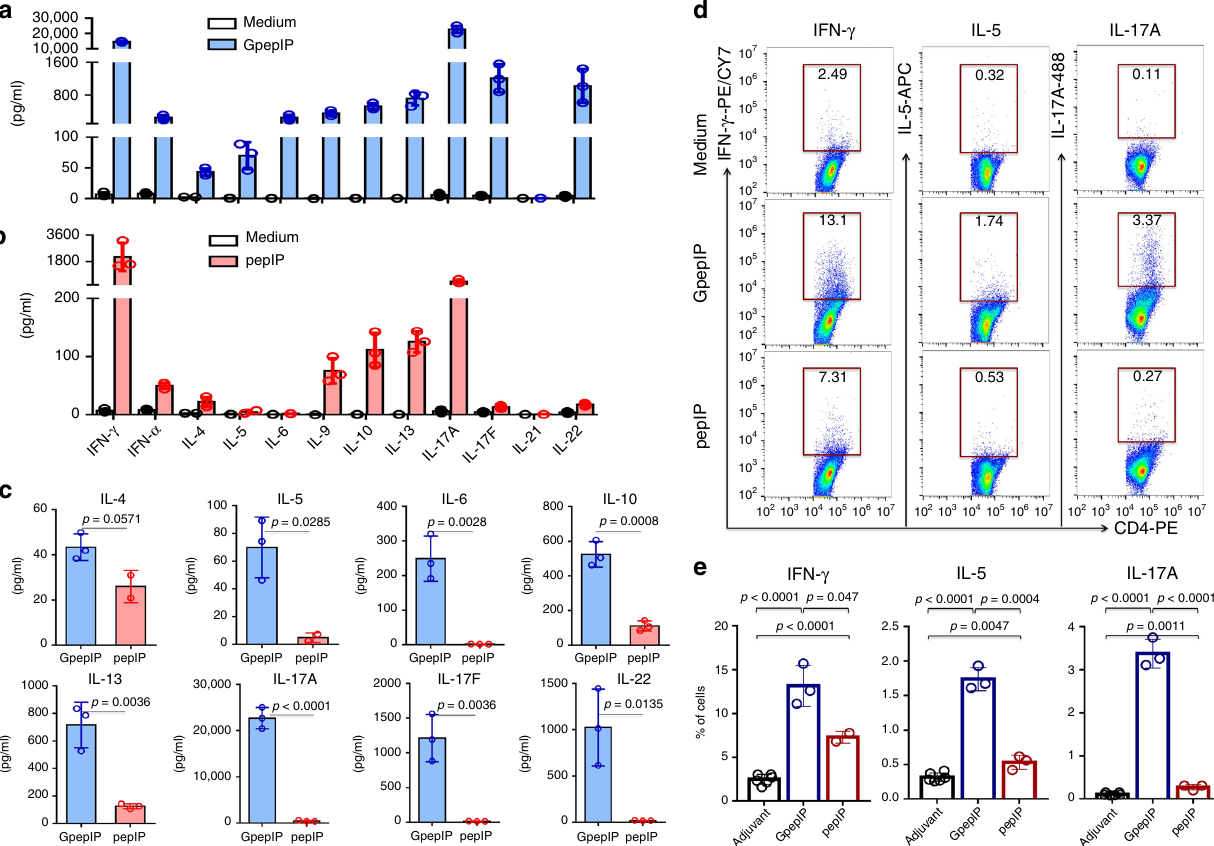
Fig. 5 Cytokine pro fi le of GpepIP and pepIP stimulation. Splenic and lymph node cells isolated from GpepIP or pepIP immunized mice were stimulated with GpepIP or pepIP, respectively, for 5 days. Th-cell-related cytokines in the supernatants from GpepIP a or pepIP b stimulation compared to no stimulation (medium) were analyzed by a multiplex-based assay. c Production of cytokines associated with Th2 (IL4, IL-5, IL-6, IL-10, and IL-13) and Th17 (IL-17A, IL-17F, and IL-22) was examined in GpepIP-stimulated and pepIP-stimulated groups. d, e Cells in a and b were stimulated with GpepIP or pepIP or in medium for 3 days. Cytokines IFN- γ , IL-5, and IL-17A on CD4 + T cells were assessed by intracellular cytokine staining and fl ow cytometry. Representative results are shown from one of two independent experiments performed. (mean ± s.d.). a – c n = 3 independent experiments. e n = 6 for medium; n = 3 independent experiments for GpepIP and pepIP. P -values were determined using Student ’ s two-sided t -tests. Source data are provided as a Source Data fi cells 26 , the expression of Il4 showed no difference between extent of its expression was strikingly lower than GpepIP groups GpepIP and pepIP (Fig. 4e). Strikingly, the expression of genes (Fig. 5c). Additionally, the expression levels of two other Th17- associated with Th17 signature was remarkably elevated in related cytokines IL-17F and IL-22 were substantially lower in GpepIP-speci fi c CD4 + T cells, including Il17a, Il17f, Il22, Iltifb, pepIP than GpepIP group (Fig. 5c). Il23r, Rorc (encoding ROR γ t), Cxcl1, Cxcl3, Lcn2, Dll4, Il1r1, Saa3, Nos2, Ptges, Lum, and Ido1 (Fig. 4e, f), indicating a robust Th17 differentiation elicited by GpepIP.